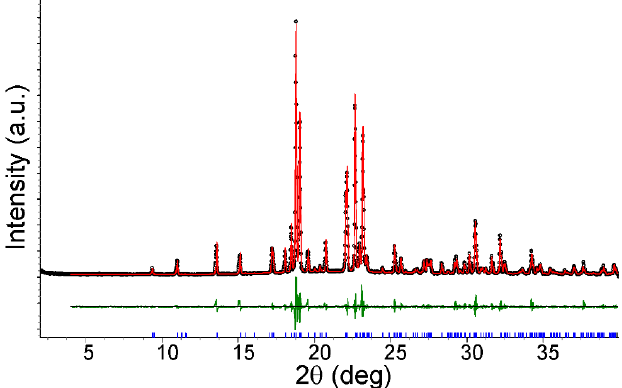
Figure 3. Pawley fit ( R wp = 12.11%, R exp = 5.47%, R p = 8.66%, gof = 2.21) of the powder X-ray diffraction (PXRD) data of 1 with a model calculated from the structure parameters derived from the single crystal structure. Black dots indicate raw data, while the red line indicates the calculated model. Tick marks (blue) are the 2 θ positions for the hkl reflections. The difference curve is shown in green.